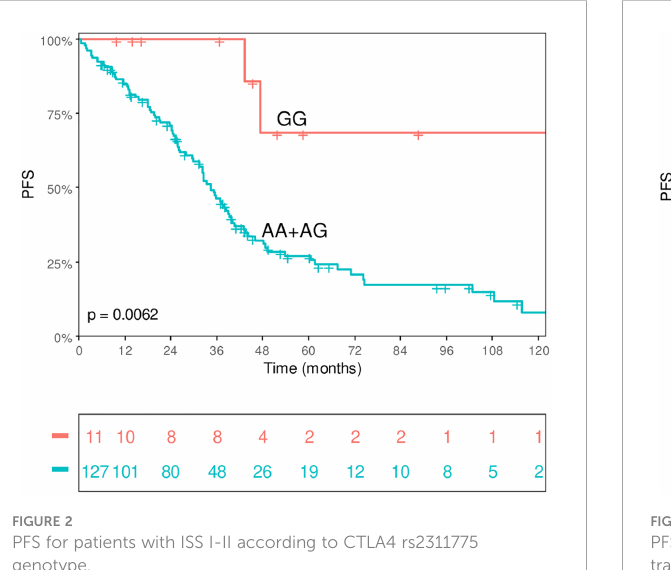
FIGURE 2 PFS for patients with ISS I-II according to CTLA4 rs2311775 genotype.